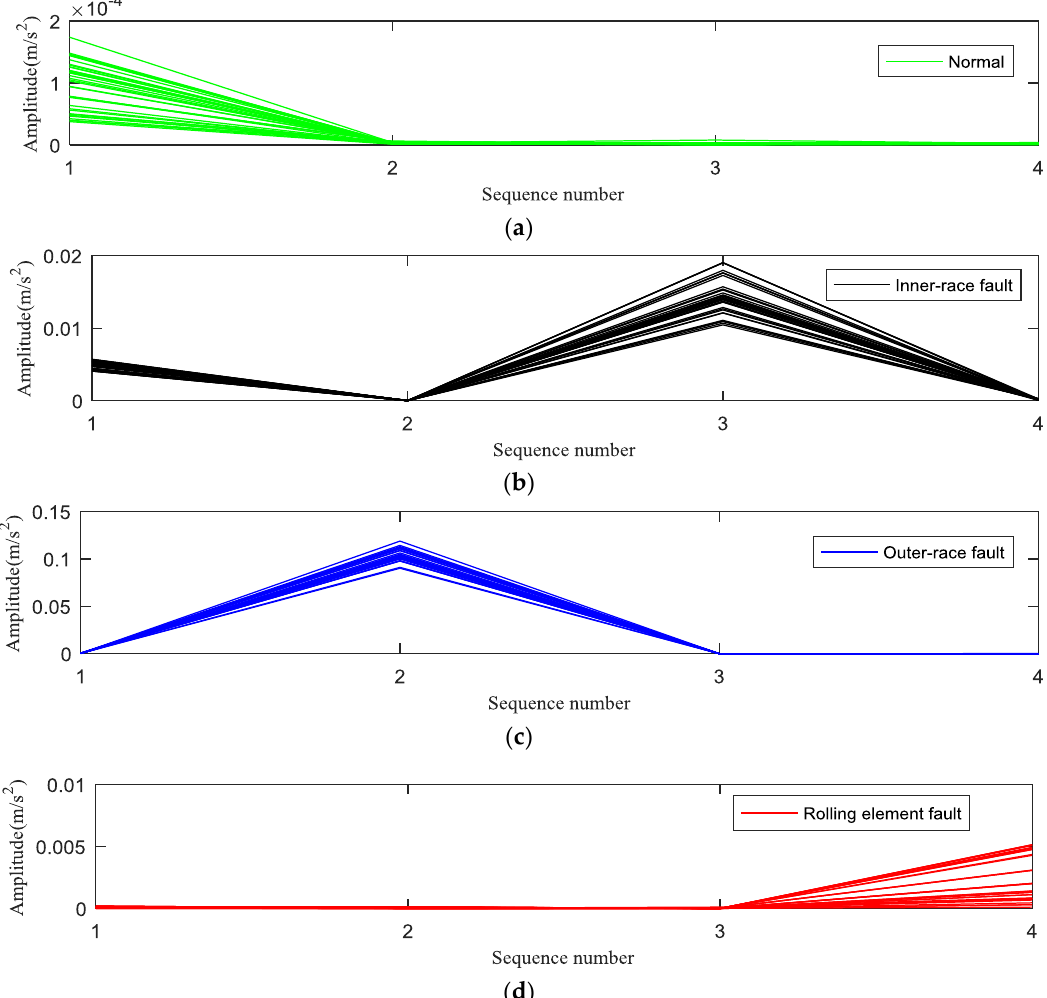
Figure 16. The fault feature vectors of: ( a ) the normal; ( b ) inner-race fault; ( c ) outer-race fault; ( d ) rolling element fault.